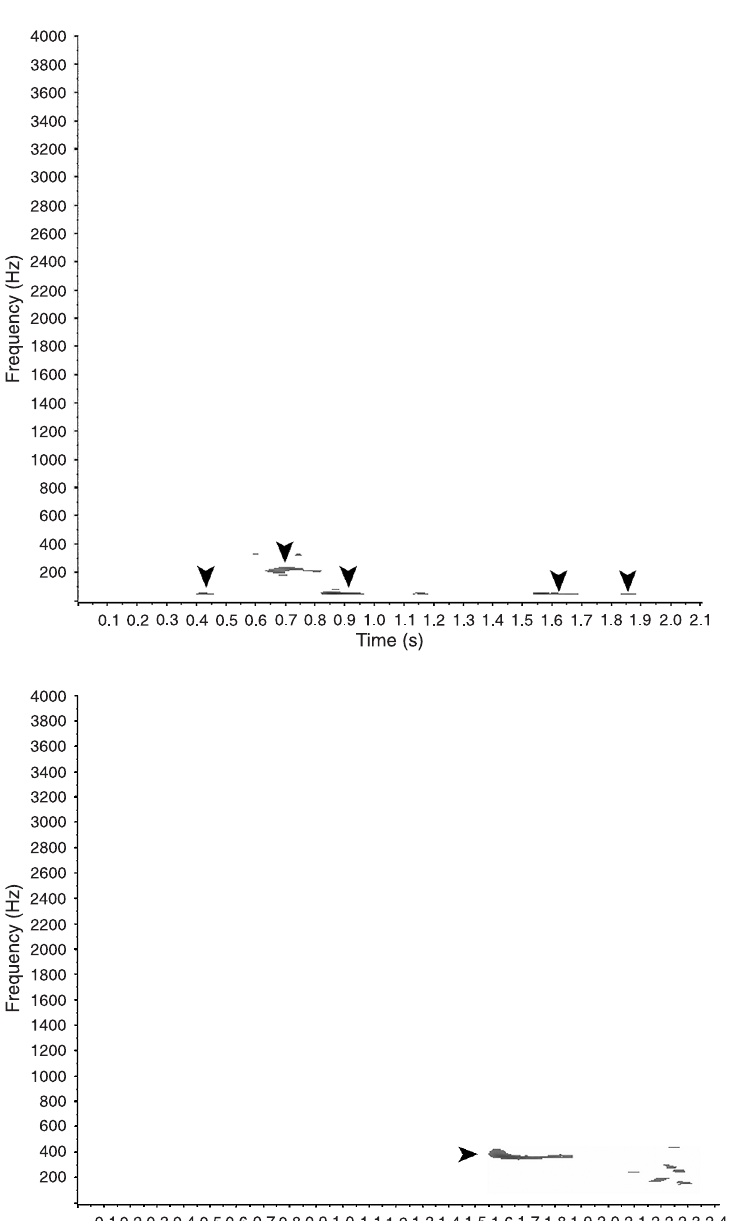
Figure 6. Spectrogram of a normal vesicular sound, presented in Figure 2, after applying the Laplacian 9 x 9 mask and threshold. After this processing, only a few spectral components re-